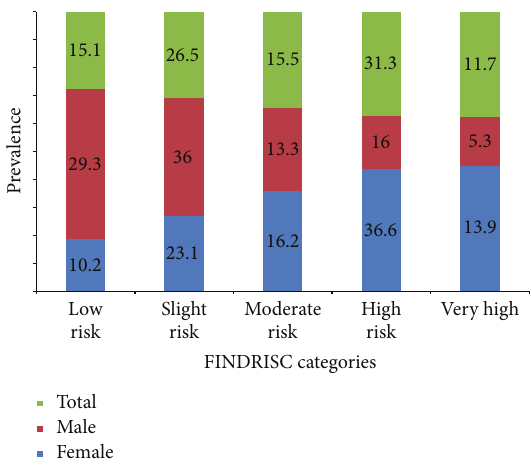
Figure 2: Distribution of FINDRISC categories by gender. The figures are percentage prevalence of each risk category by gender compared to the total prevalence in each category. Females had significantly higher prevalence of high risk categories than men ( 𝑃 - value <